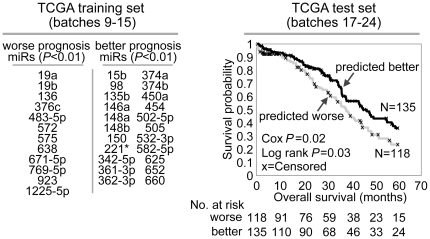
MiRNAs correlated with patient survival in ovarian cancer.Using a training dataset of TCGA miRNA expression profiles, a prognostic miRNA signature was defined (left panel) and then applied to a test dataset (right panel), each tumor being assigned a score measuring how well the tumor's expression patterns reflected those of the signature pattern. Kaplan-Meier analysis (log-rank tests) compares time to death for ovarian cancer patients showing higher risk (prognostic score>0) versus lower risk (prognostic score<0). Univariate Cox test treats the prognostic score as a continuous variable. (miR-923 was recently determined to be an rRNA fragment, according to miRBase.).